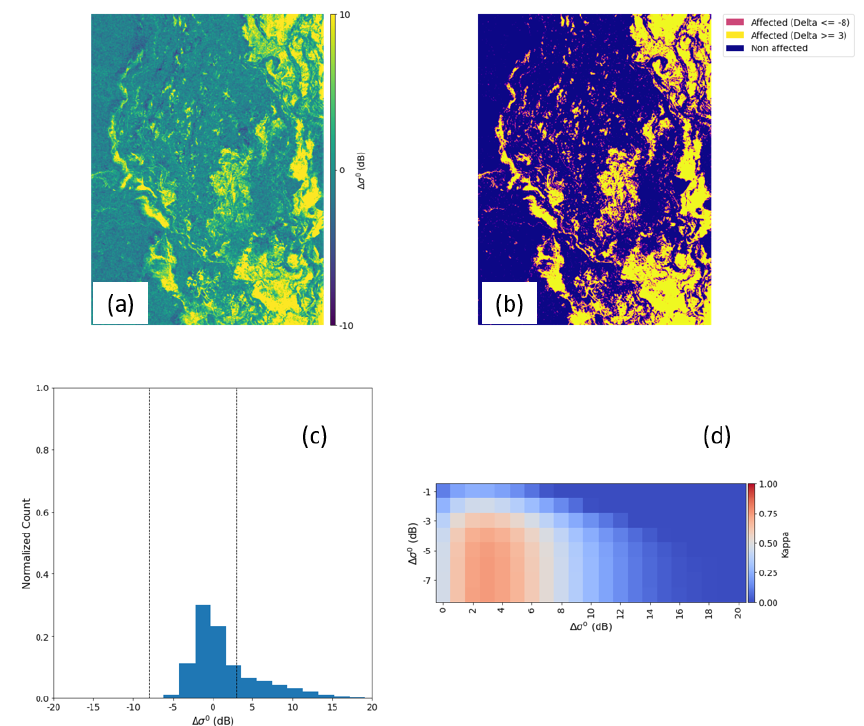
Figure 12. Mozambique ConvLSTM Delta image of VV polarization ( a ), Flood Proxy Map ( b ),